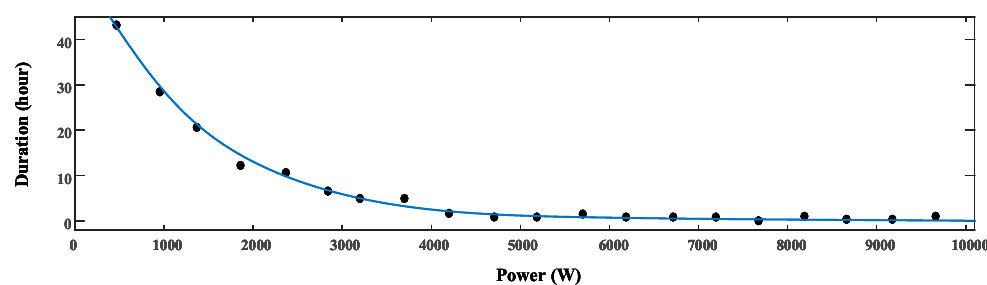
Figure 5. The electricity demand distribution curve for the terraced house which was built approximately 30 years ago.